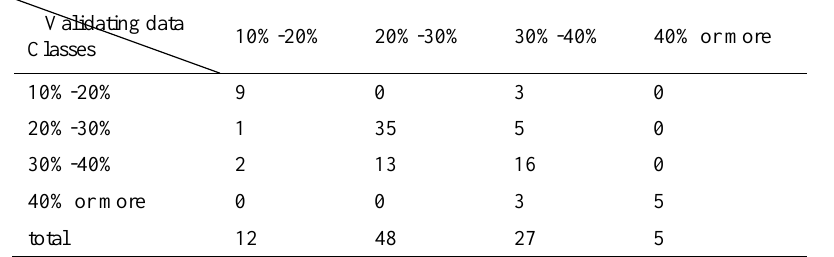
Table 3. The precision analysis in vegetation coverage area